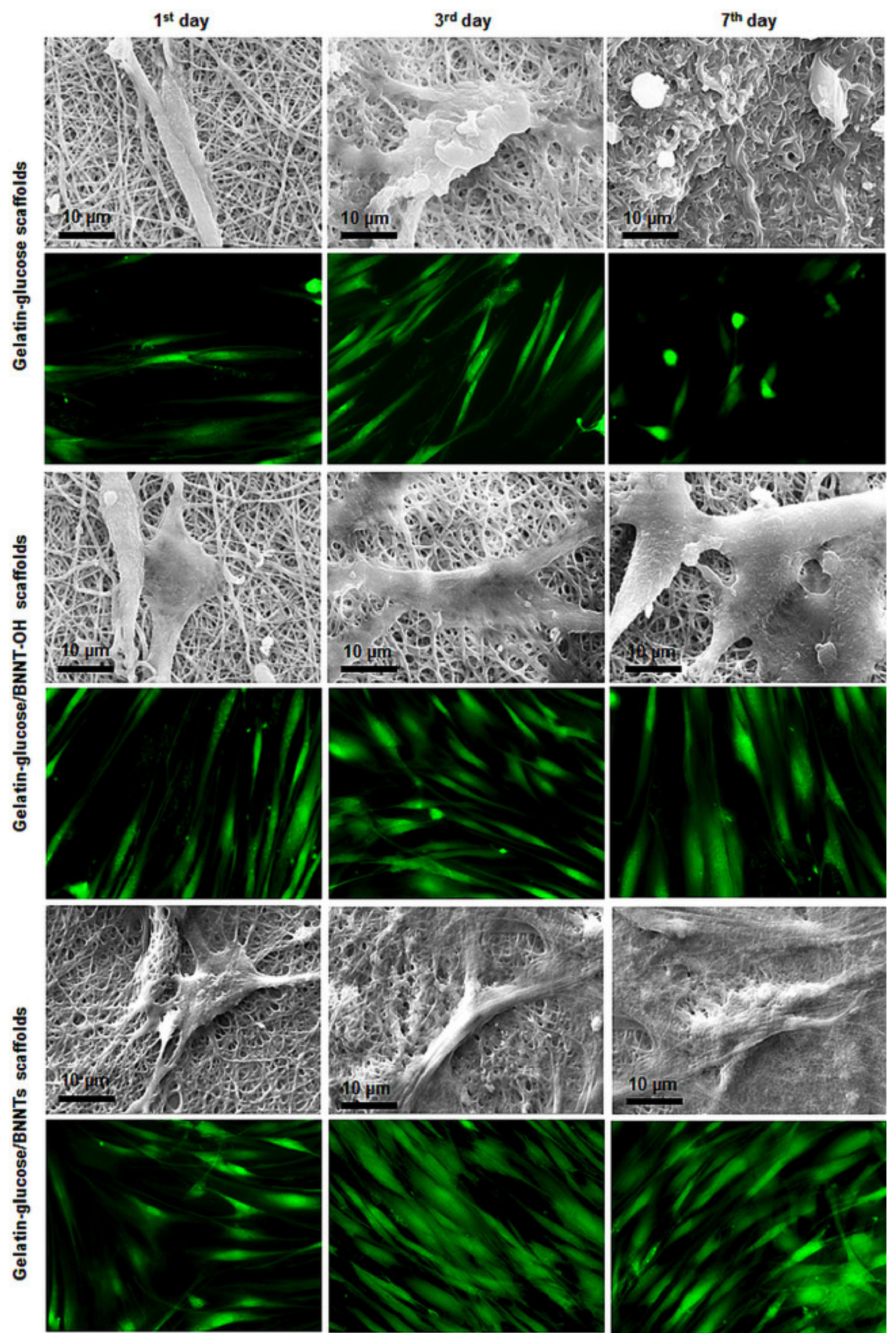
Figure 5. Microscopy images of HDF cells growing onto the BNNTs reinforced gelatine and glucose scaffolds. Reproduced with permission from Ref [51]. Copyright 2015, Elsevier.